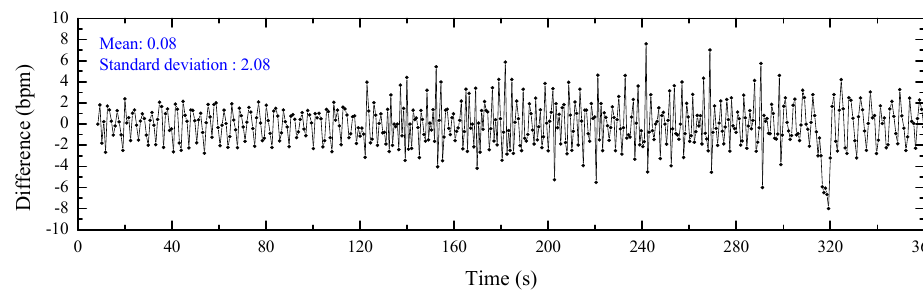
Figure 11. Heart rates estimated from ECG and SCG.